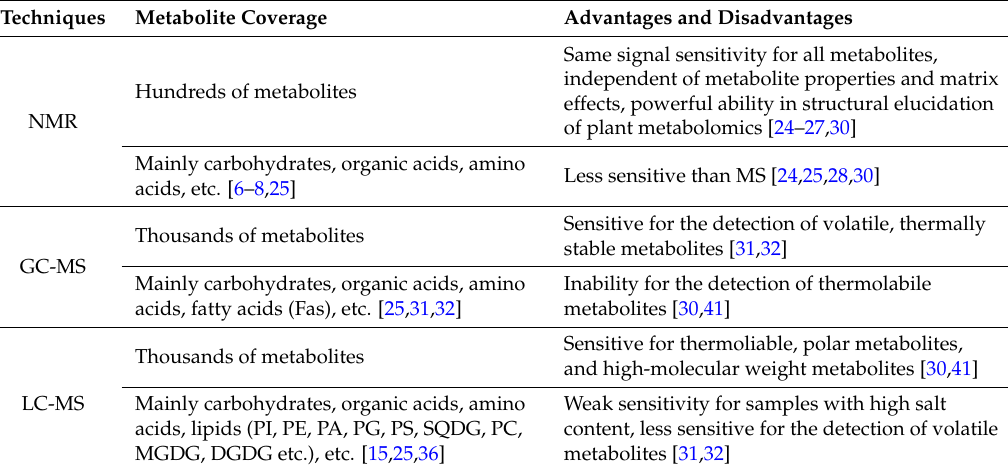
Table 1. Coverages of plant metabolome by NMR and GC/LC-MS techniques.